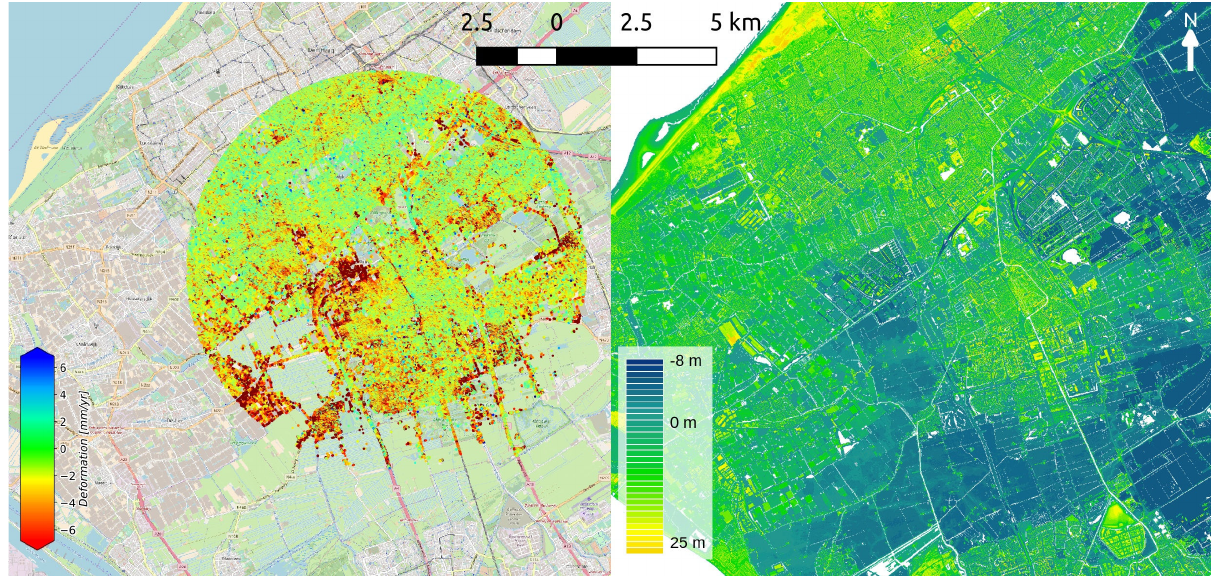
Figure 1. Left: PS-InSAR data from both ascending and descending orbits. The city of Delft is hidden below the points. The Hague can be seen in the north and the northern part of Rotterdam in the south. (Backgroud: OpenStreetMap) Right: digital surface model extracted from AHN3 of the same region.